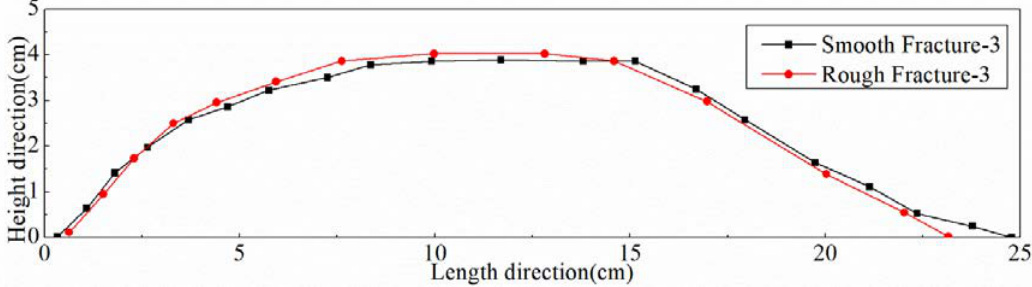
Figure 16. Comparison of proppant distribution in smooth and rough fracture (t = 2 s).